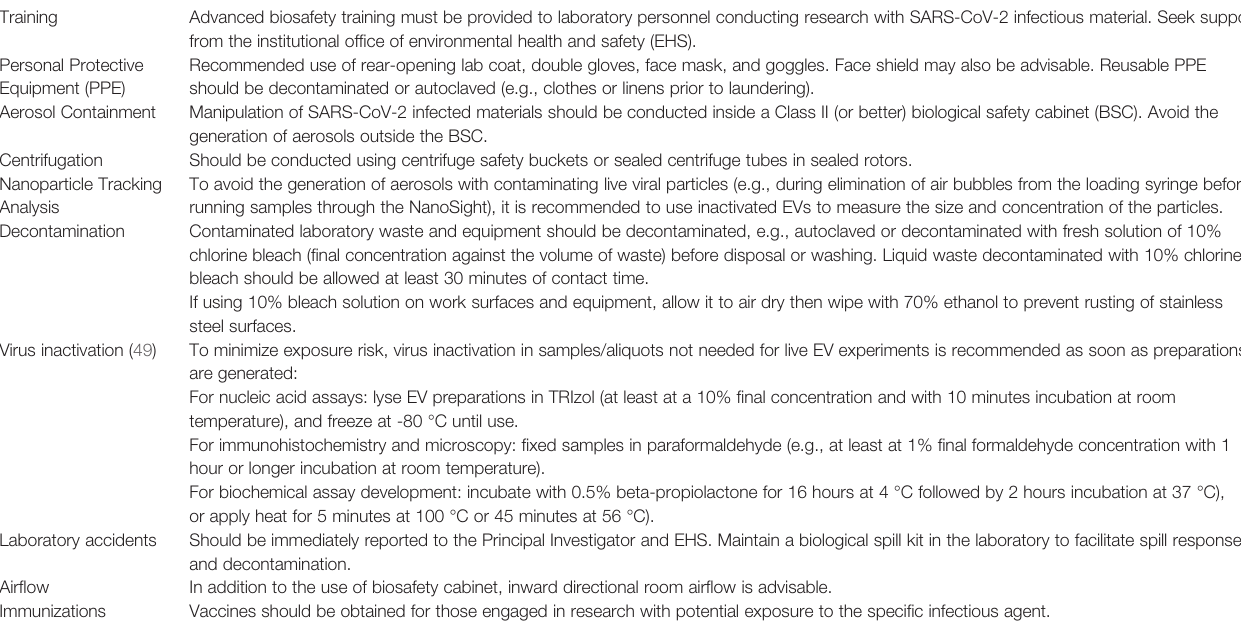
TABLE 1 | Biosafety recommendations for work involving the isolation and use of extracellular vesicles (EVs) from SARS-CoV-2 infected samples.